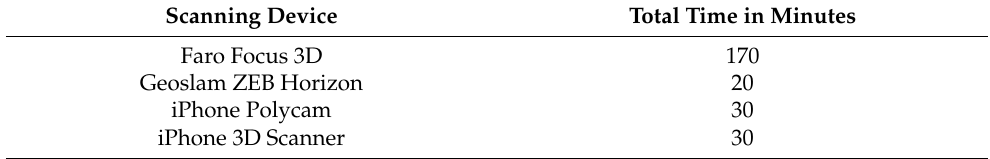
Table 1. Comparison of time required for data collection of all sections 450 m long of the forest road.